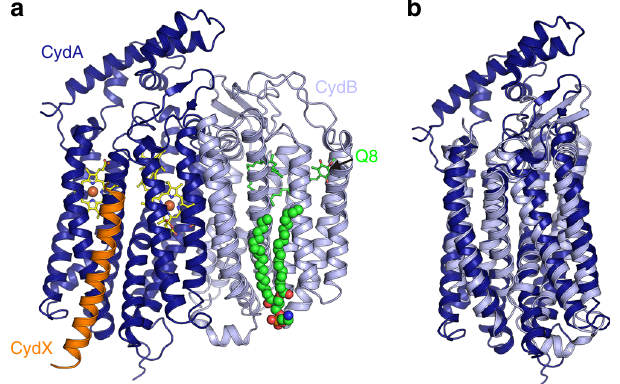
Fig. 1 Cryo-EM structure of E. coli bd oxidase at 3.3 Å resolution. a Subunits CydA (dark blue) and CydB (light blue) comprise nine TM helices each. CydX (orange) is a single-TM helix, serving as clamp for the four-helix bundles coordinating hemes b 558 and b 595 (shown as sticks). Ubiquinone-8 (Q8) and a glycerophospholipid (shown in spheres) are bound to CydB. b CydA and CydB share the same fold, highlighting their homology. The extended lid of the Q binding site at the periplasmic side of the membrane (top), the Q-loop, is unique for